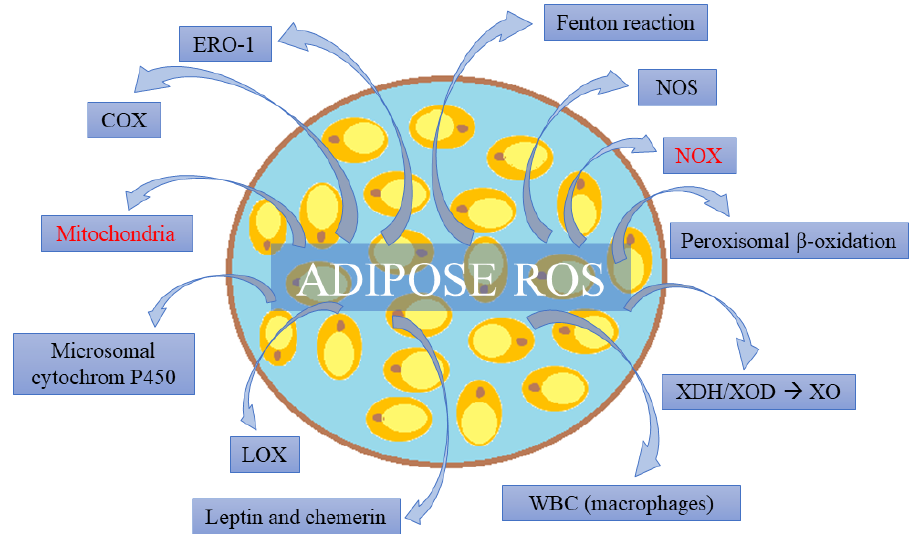
Figure 1. Adipose tissue as a source of reactive oxygen species (ROS). The main sources are mitochondria and reduced nicotinamide adenine dinucleotide phosphate (NADPH) oxidase (NOX). (ERO-1) endoplasmic reticular oxidoreductin 1, (COX) cyclooxygenase, (LOX) lipoxygenase, (WBC) white blood cells, (XDH) xanthine dehydrogenase, (XOR) xanthine oxidoreductase, (XO) xanthine oxidase, and (NOS) nitric oxide synthase.